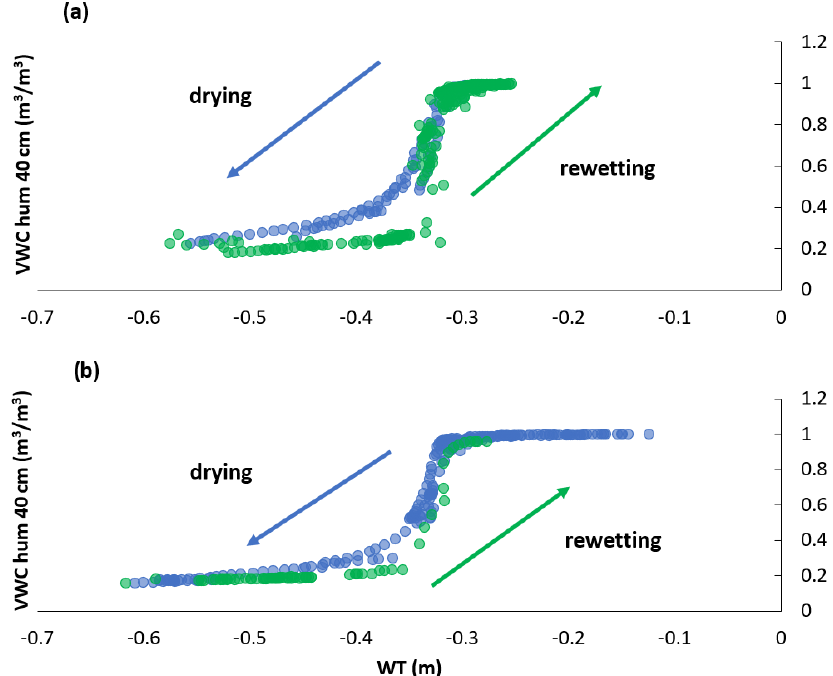
Figure 2. Hysteresis (a) in 2018 and (b) in 2019, between WT depth (m) and volumetric water content (VWC, m − 3 m − 3 ) at 40cm depth in the